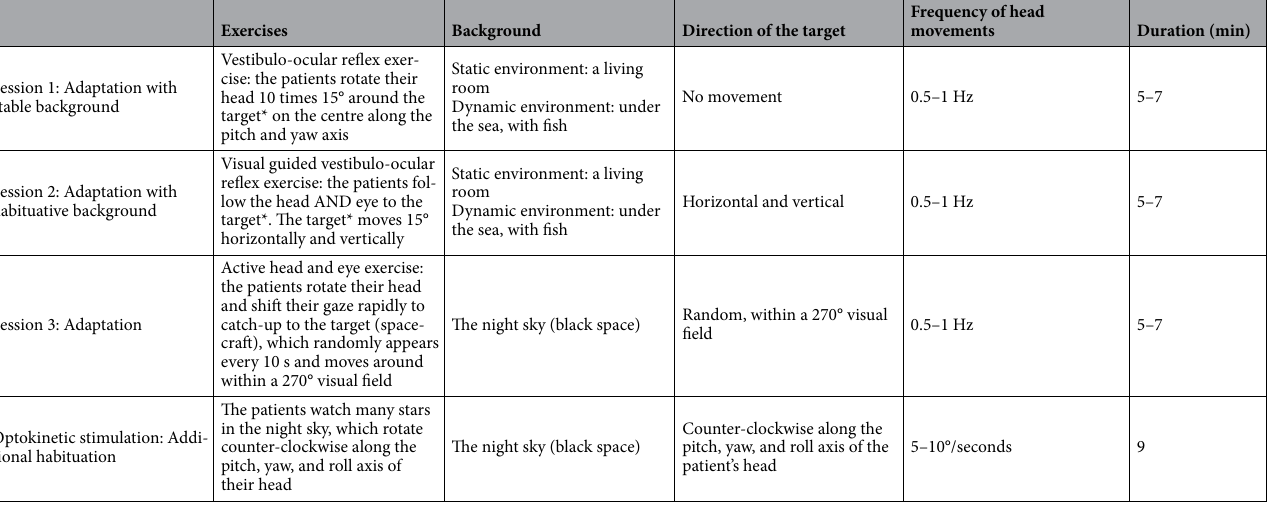
Table 2. Vestibular exercise customized on adaptation and habituation. The target* in sessions 1 and 2 looks like a robot, which can move horizontally and vertically, one metre ahead along the centre. The target guided the participants to follow and let them know whether they were exercising exactly 15 degrees around the centre. When the participants successfully completed the exercise 10 times, they could increase the